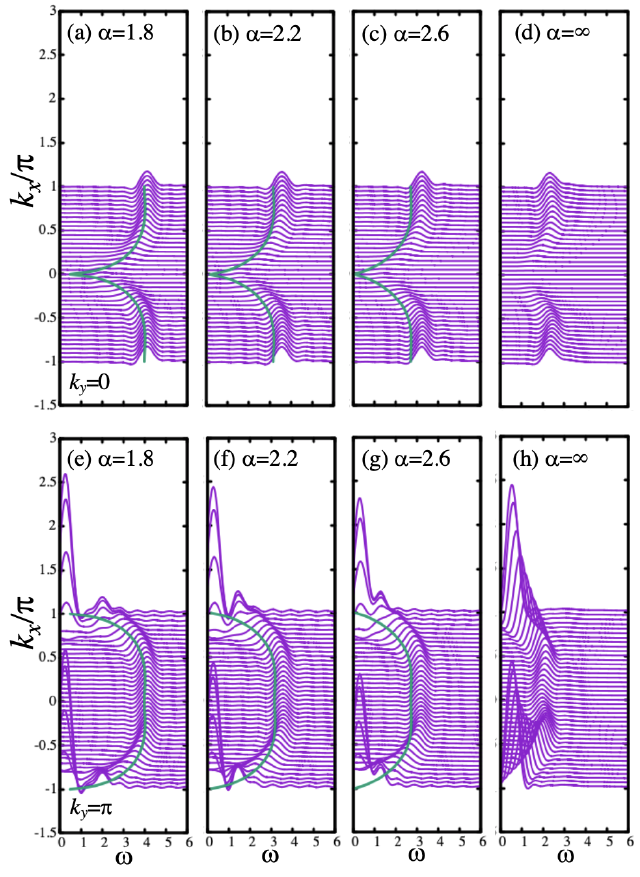
Figure 7: Longitudinal dynamic spin structure factor S ( k , ω ) for a 20 × 2 ladder with long range interactions and different exponent α across the quantum critical point, obtained with tDMRG. Upper(lower) row show the symmetric (antisymmetric) channel. Ringing at high energies is due to the finite time integration window (see text). Also shown are the linear spin-wave dispersion and results for the conventional ladder with only nearest-neighbor terms, α = ∞